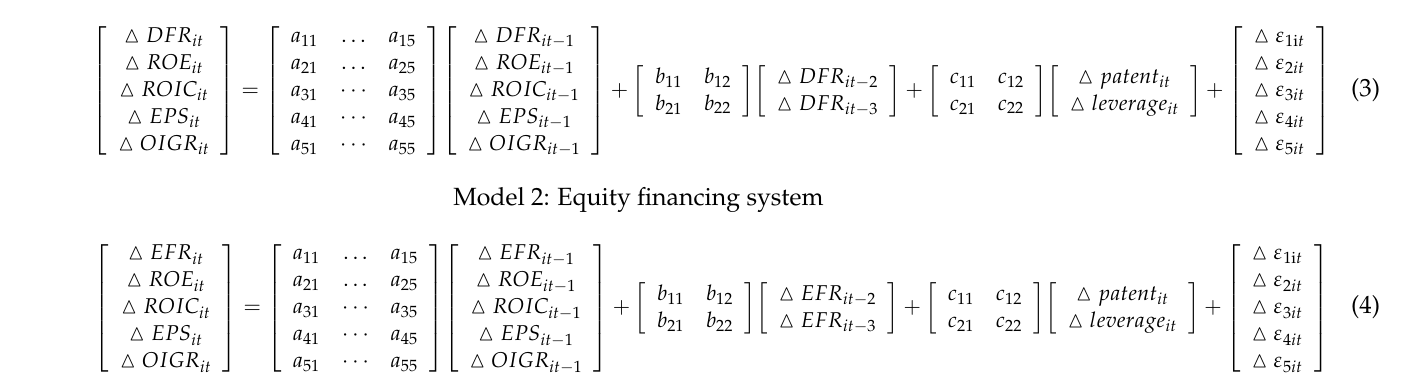
Model 1: Debt financing system